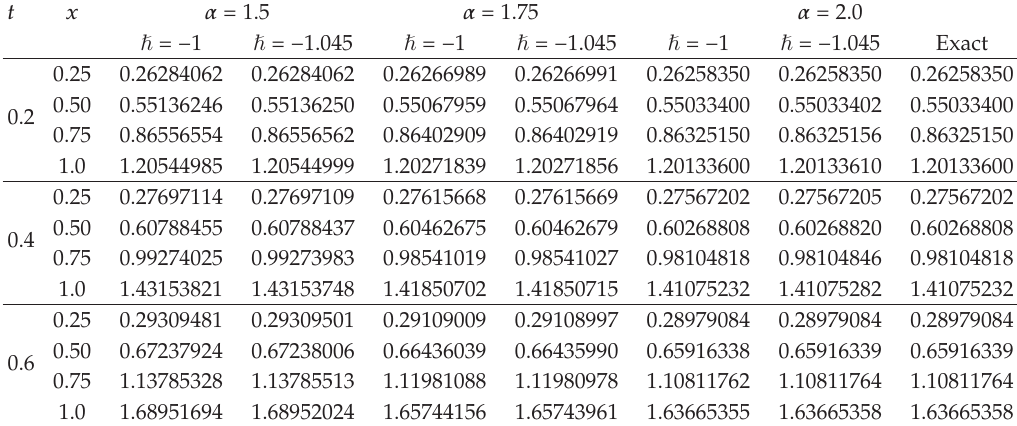
Table 1: Approximate solution of (cid:3) 4.1 (cid:4) for some values of α using the 4-term HAM approximation, φ (cid:2) (cid:8) − 1 and (cid:2) (cid:8) − 1 .